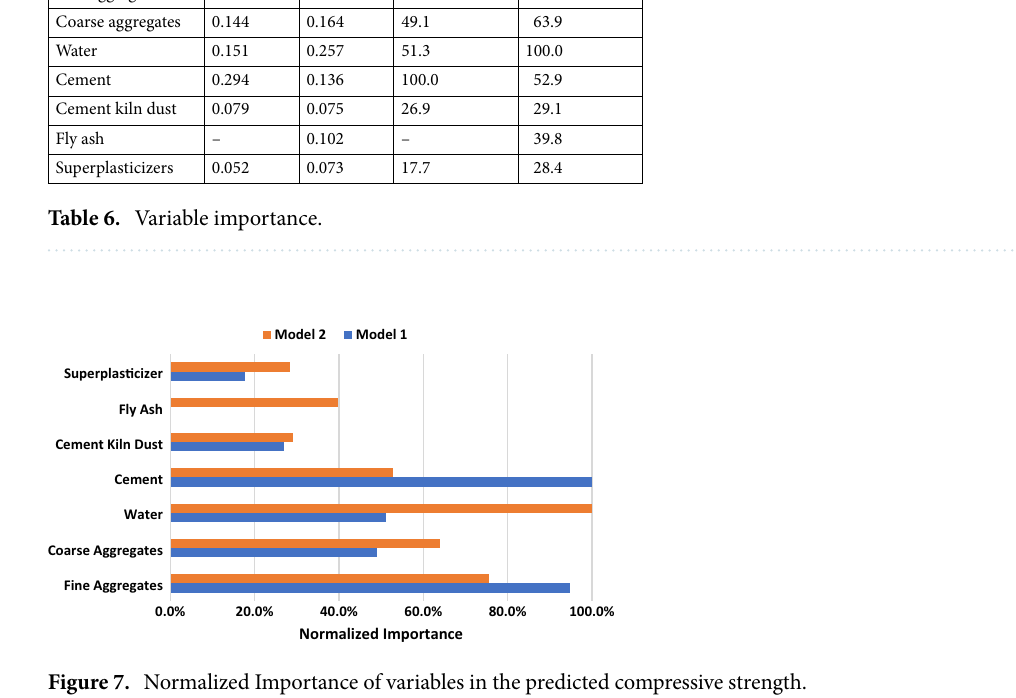
Figure 7. Normalized Importance of variables in the predicted compressive strength.